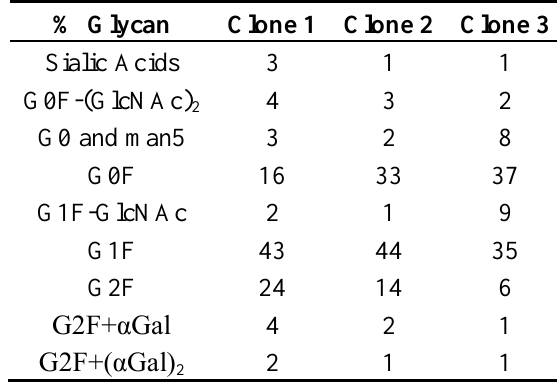
Table 1. % Glycan compositions from three different clones. %